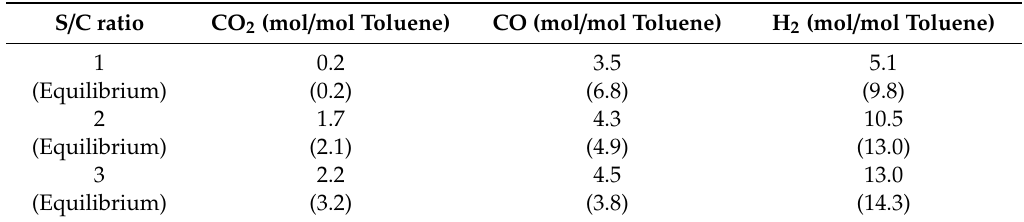
Figure 6. Toluene conversion to C-containing gases and CO / CO 2 selectivity at di ff erent S / C ratios (GHSV:61,200 h − 1 , 800 ◦ C). Table 5. Product yields for the gaseous products under di ff erent S / C ratios (GHSV:61,200 h − 1 , 800 ◦ C).